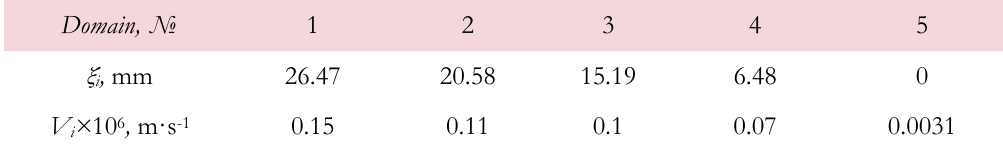
Table 3: Velocities of the deformation zones at the pre-fracture stage for steel